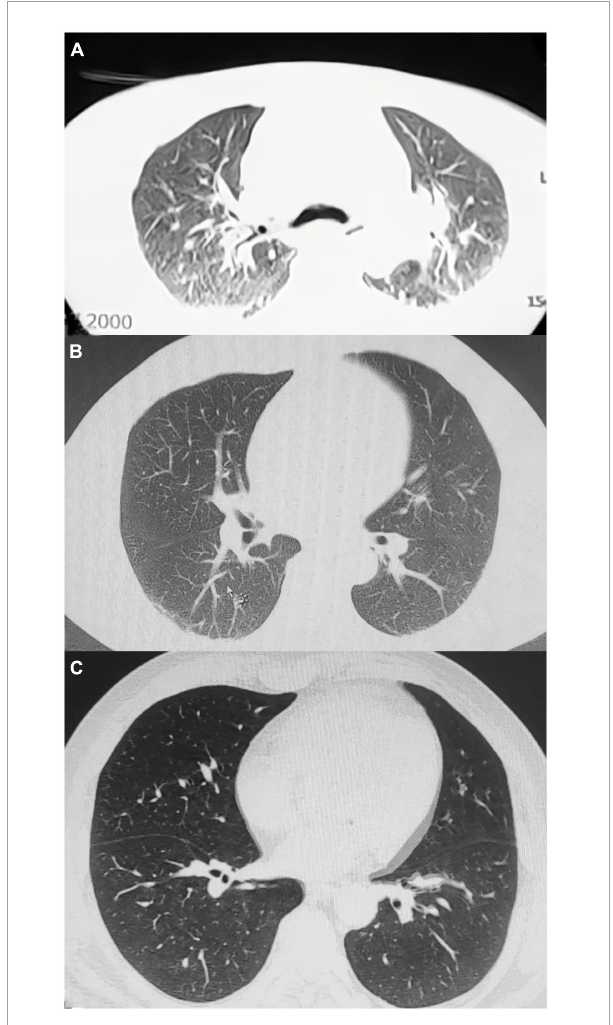
FIGURE1 Computed tomography changes in the patient’s lungs. (A) Increased and disordered bronchovascular bundles in both lungs, blurred and poorly defined boundaries, multiple patchy high-density shadows, mainly in the lower lobe, and curved fluid density shadows in the bilateral thorax. (B) Increased texture of both lungs, patchy high-density shadows on the dorsal side of both lungs, multiple solid microscopic nodules in both lungs, and a small fluid density in the bilateral thorax. (C) Multiple micronodules are observed in both lungs, and a few fibrous foci are observed in the left